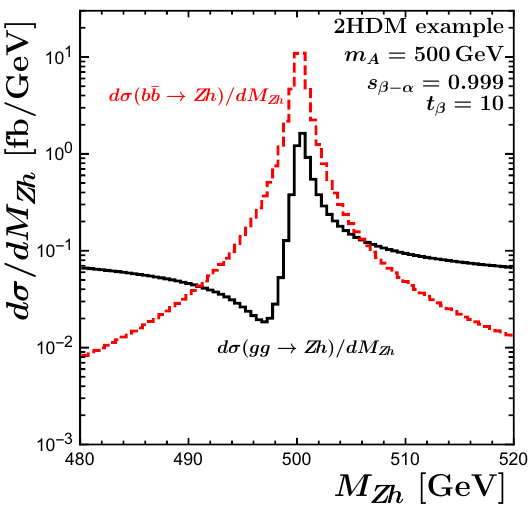
Figure 6 . The cross sections gg ! Zh (black) and b (cid:22) b ! Zh (red) as a function of the invariant mass of the Zh system for the LHC at 13 TeV. The shapes are determined by the interference of the resonant gg=b (cid:22) b ! A ! Zh contributions with all other